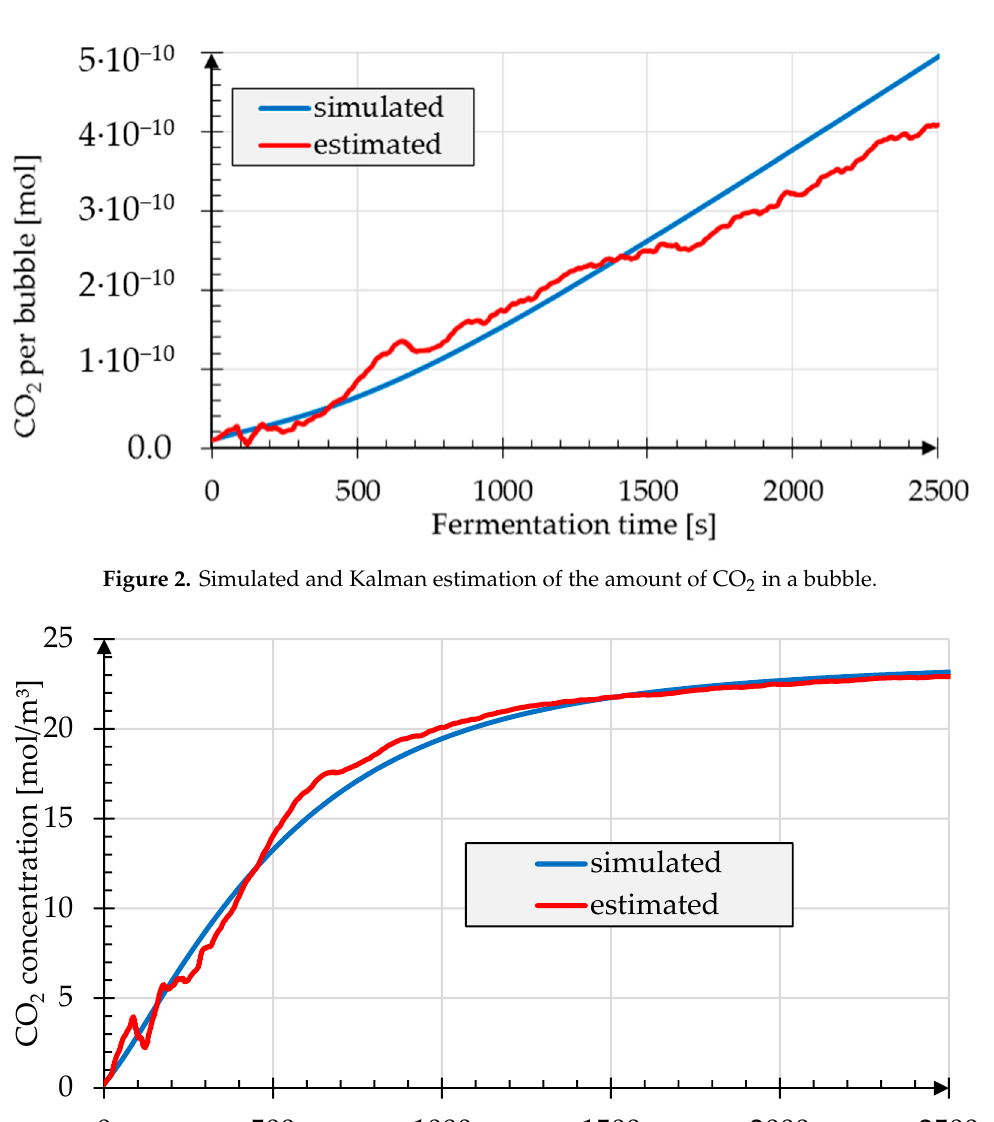
Figure 2. Simulated and Kalman estimation of the amount of CO 2 in a bubble.